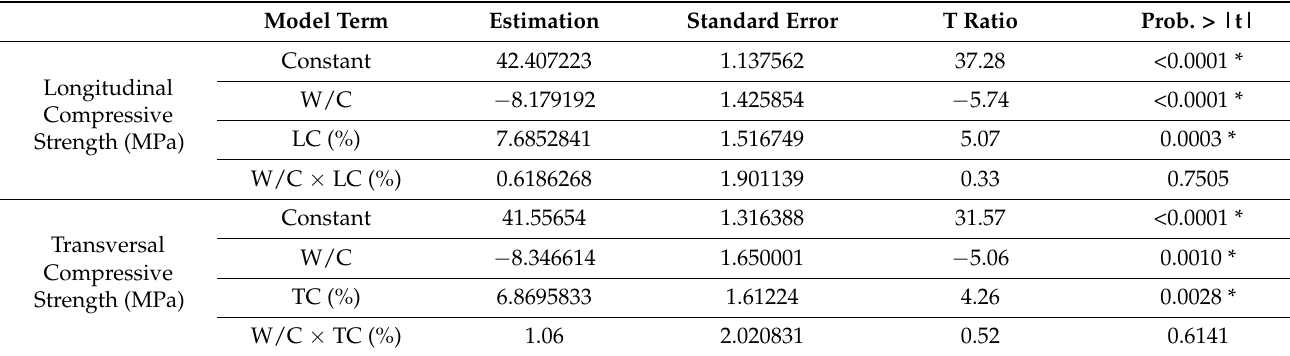
Table 11. Effect